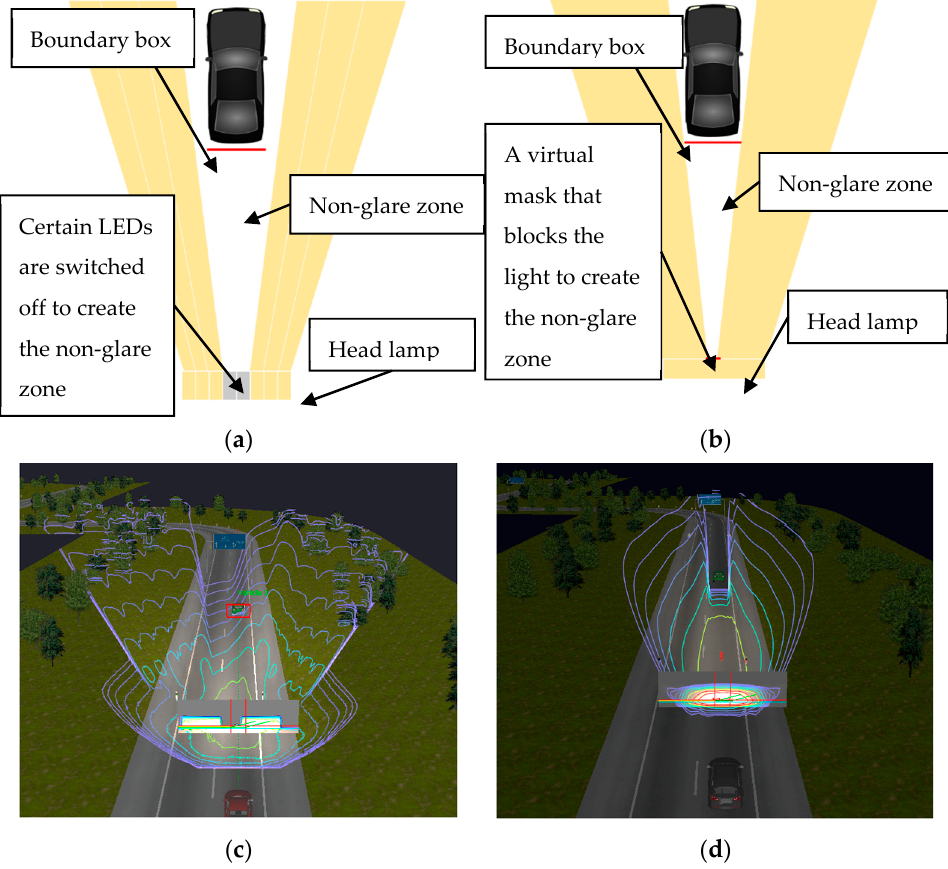
Figure 2. Comparison of pixel masking and matrix beam showing the difference of two simulation algorithms: ( a , c ) ADB simulation using matrix beam algorithm, in which each segment can be switched on/off individually; ( b , d ) ADB simulation using pixel-masking algorithm, which uses one beam pattern, with the boundary box of the stimulus vehicle masked